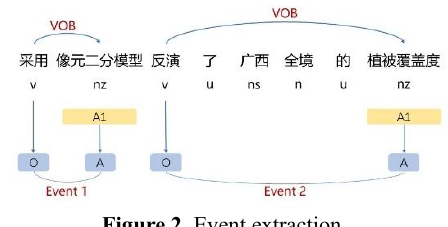
Figure 2 . Event extraction.